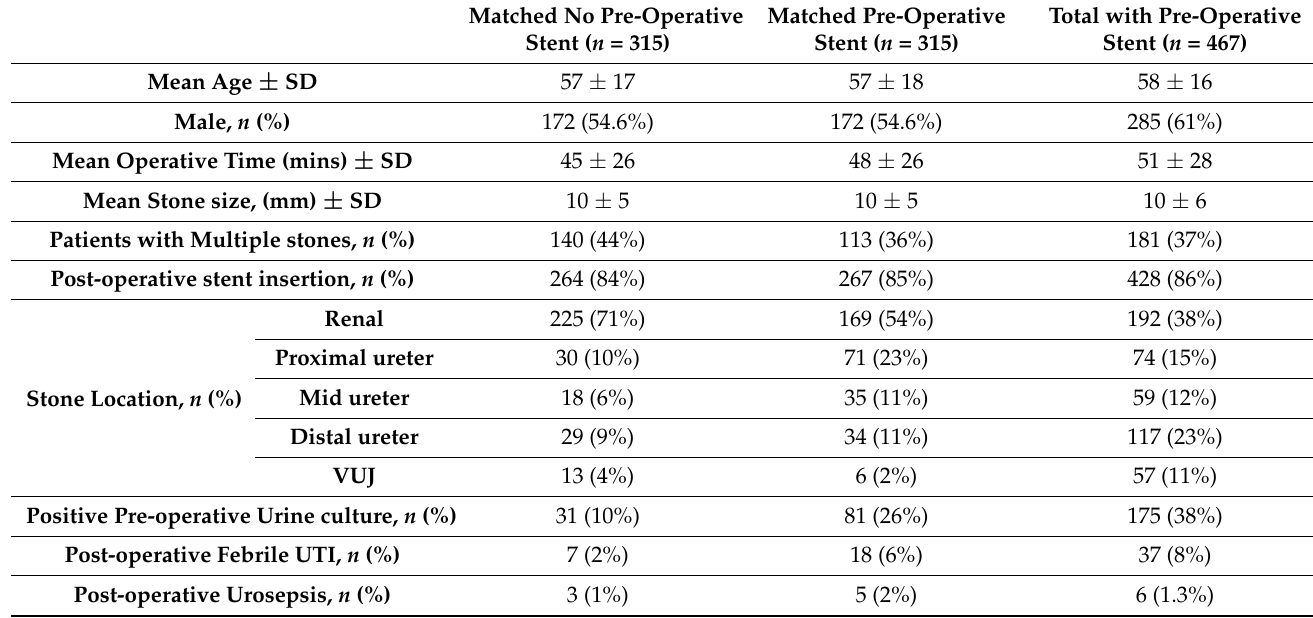
Table 1. Patient demographics in the